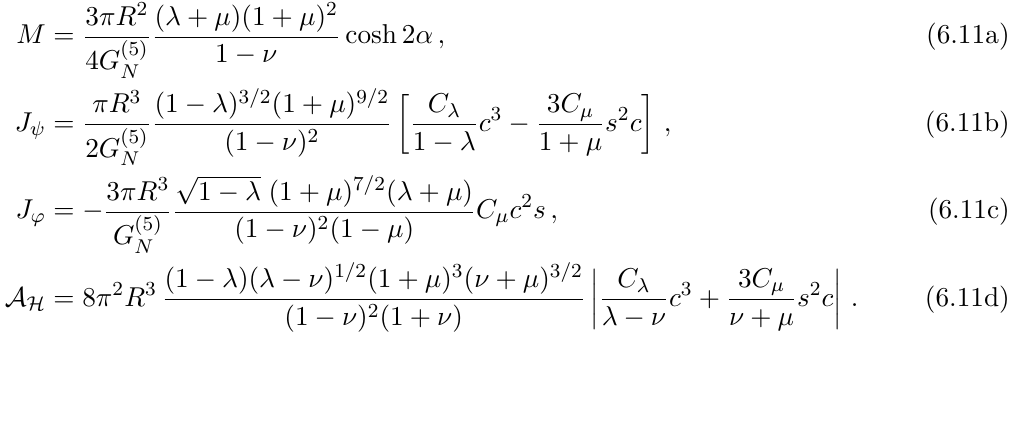
JHEP07(2021)007